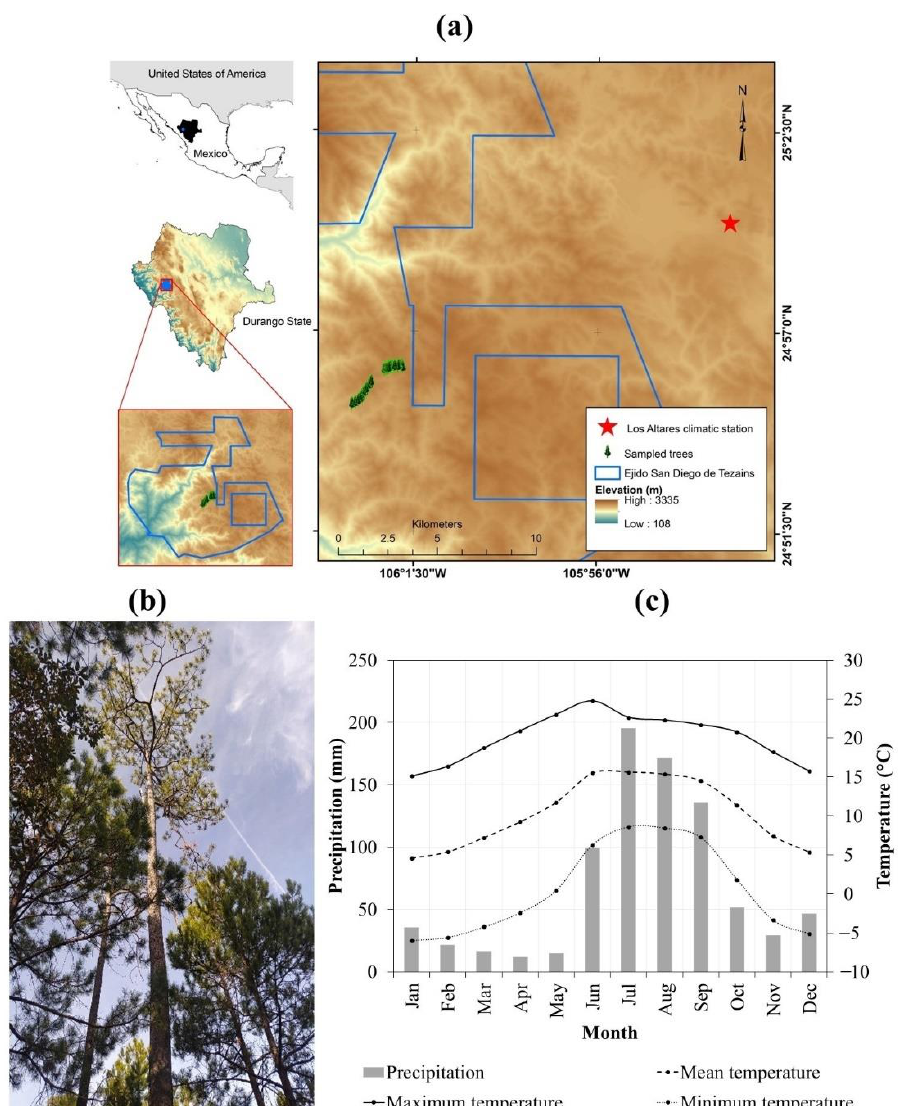
Figure 1. ( a ) Location of the study area; ( b ) photograph of a Pinus durangensis specimen; ( c ) mean monthly weather conditions from 1973 to 2019.